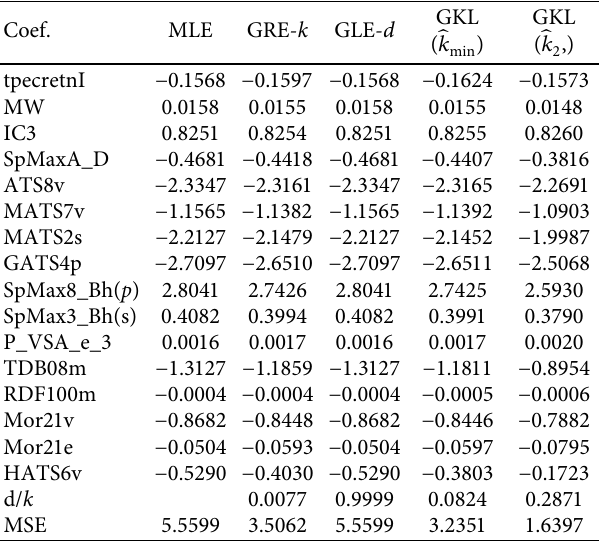
Table 4: Application result using the proposed and existing estimators.